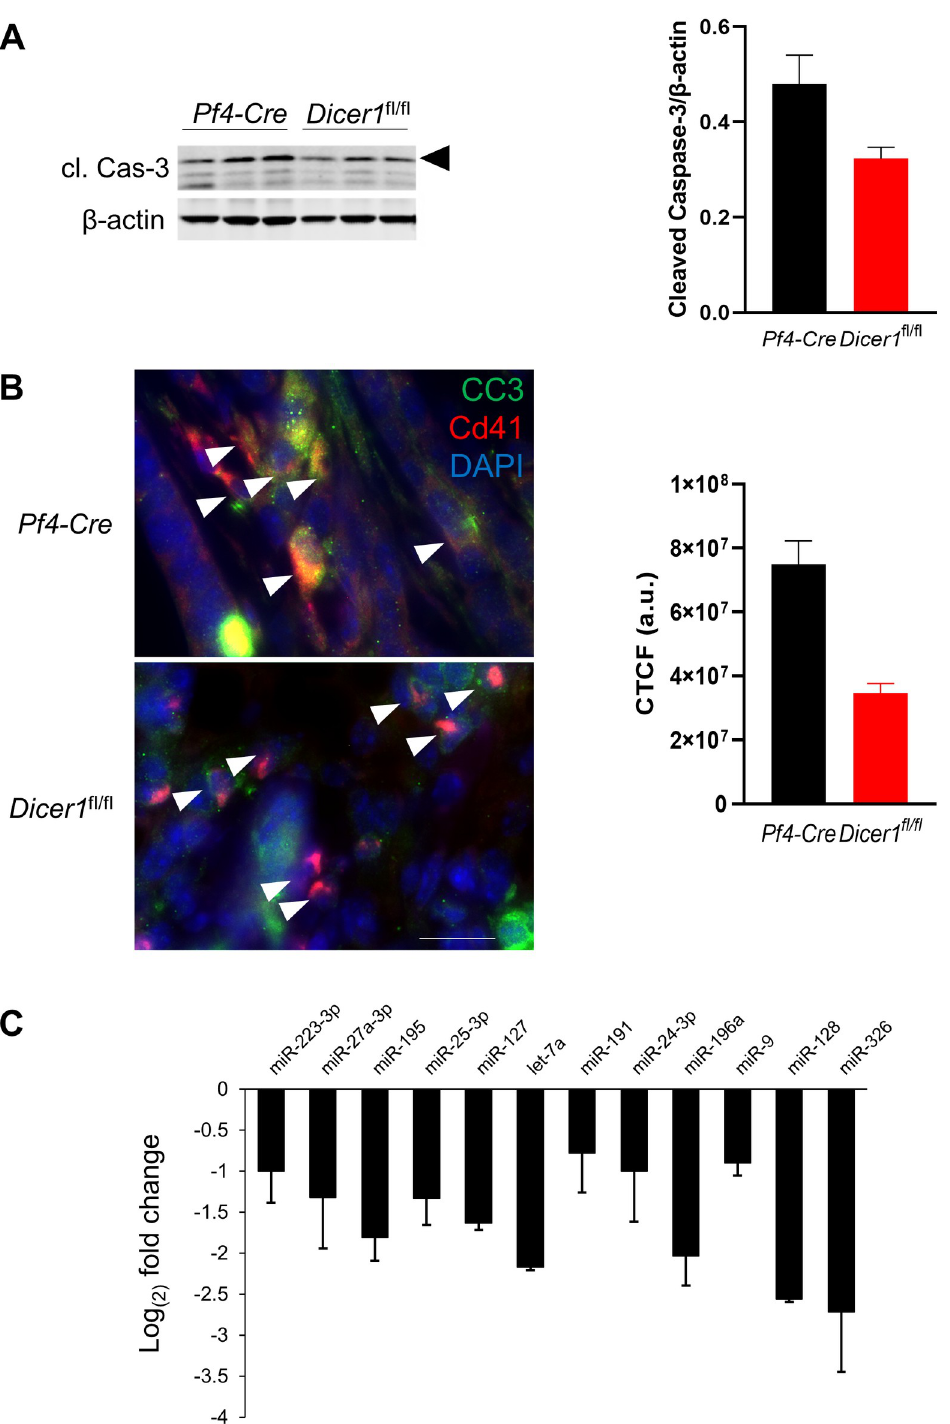
Fig 2. Platelet miRNA- and microvesicle-associated tumor cell apoptosis. A Representative western blots of cleaved Caspase-3 (cl. Cas-3, arrowhead) and β -actin in whole tumor lysates, three for each host animal genotype. Densitometric measurements of cleaved Caspase-3/ β -actin ratios are shown below + s.e.m. n = 6. � , p < 0.05; #, p < 0.02. B Representative sections of KPC tumors resected from Pf4-Cre or Dicer1 fl/fl / Pf4 -Cre mice, immunostained with antibodies to cleaved Caspase-3 (CC3, green), Cd41 (red), and Epcam to identify and outline tumor cells (not shown), followed by DAPI (blue) to show nuclei. White arrowheads point to selected tumor cells with platelet- or